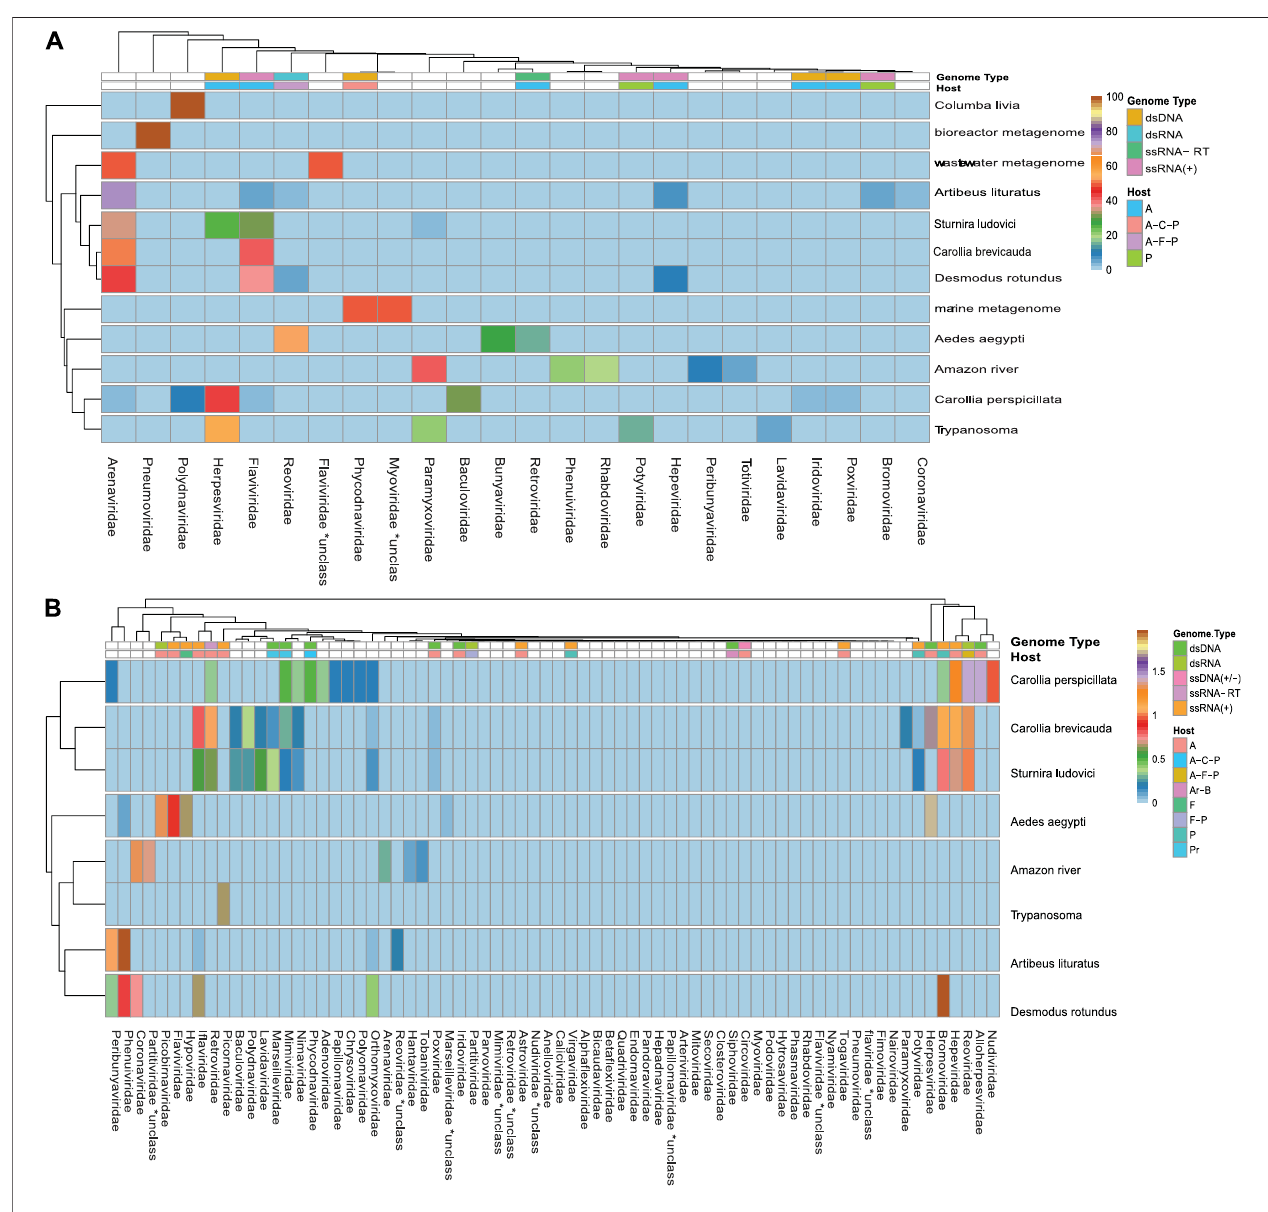
FIGURE3| Rateofviralsequencesdetectedineachmetagenome. (A) Theproportionsoffamiliesrecovered withBlastn. (B) Theproportionsoffamiliesrecovered using contigs translated with Blastp. The RVDB-v21 database reference was used in both methods.